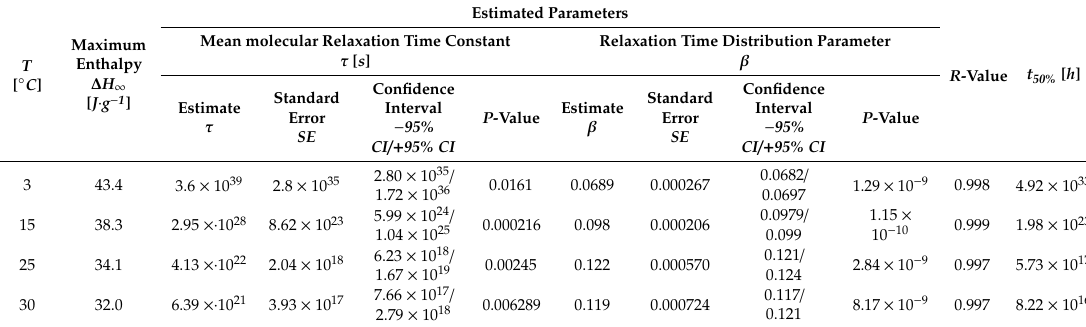
Table 2. The results for the best fit to the Kohlrausch–Williams–Watts (KWW) equation.